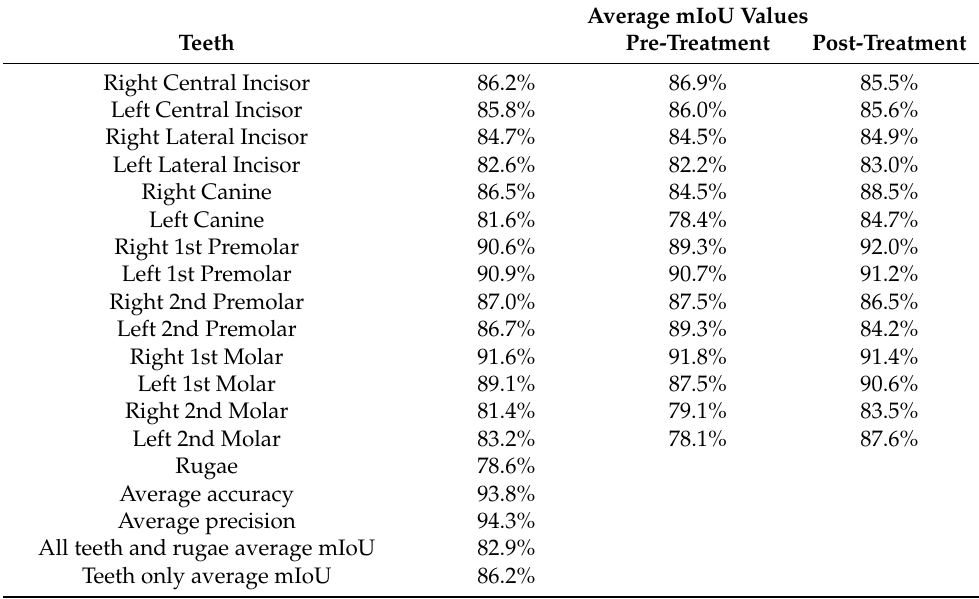
Table 5. Dataset analysis